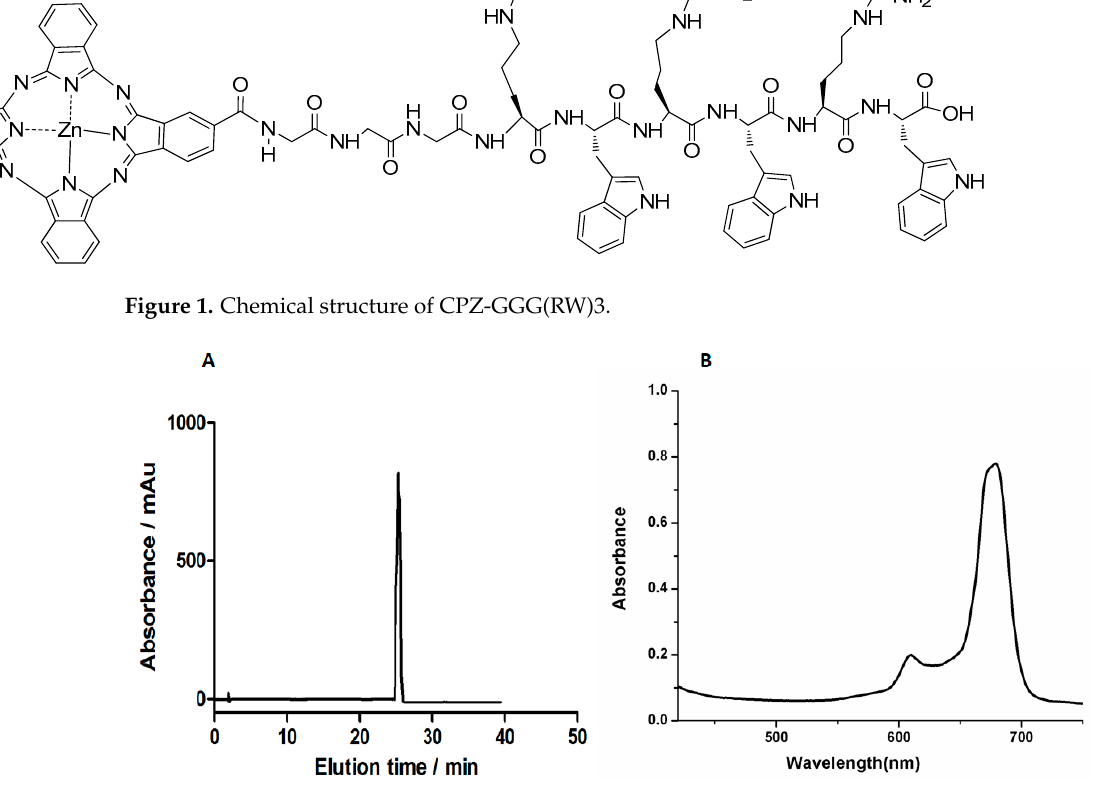
Figure 2. Characterization of CPZG-GG(RW)3. (A ) C-18 reversed-phase analytical HPLC chroma- togram for CPZG-GG(RW)3. ( B ) UV/Vis absorption spectrum of CPZ-GGG(RW)3 in DMSO in the range of 550–800 nm.